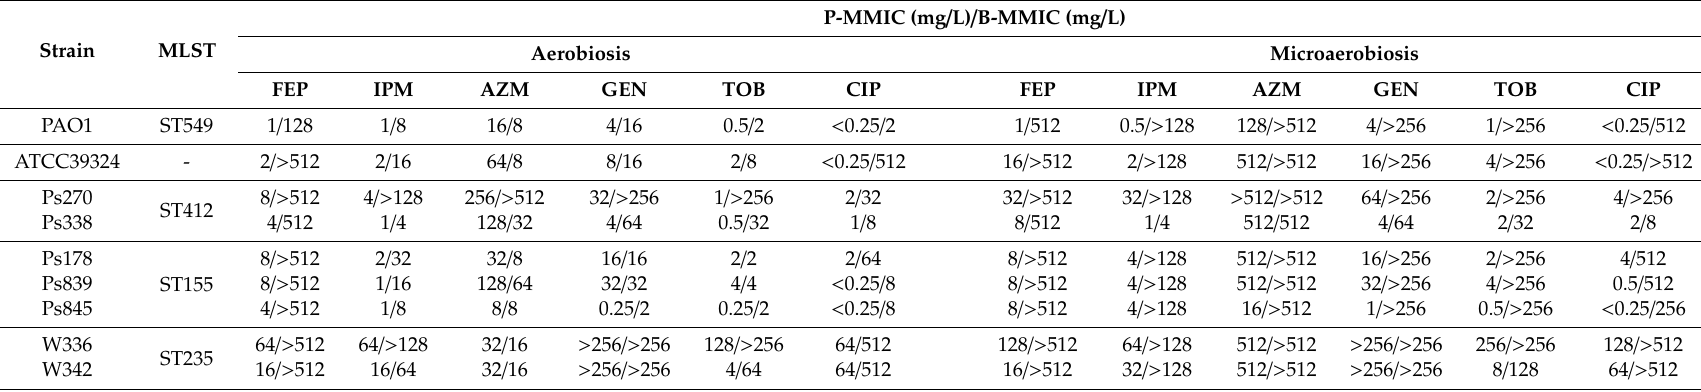
Table 3. P-MMICs and B-MMICs of di ff erent antimicrobial agents against the clinical and non-clinical P. aeruginosa strains using SCFM artificial medium 1 .